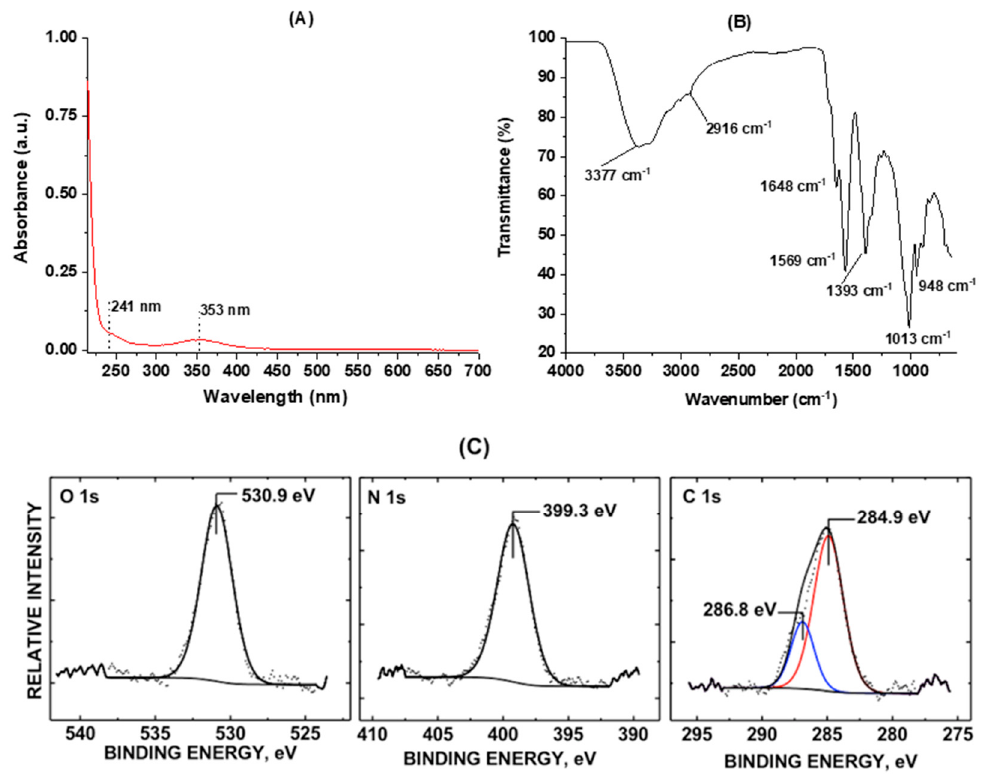
Figure 2. Spectroscopic characterization of the “B-doped” C-dots: ( A ) UV-Vis absorption spectrum of C-dots; ( B ) Fourier-transform infrared (FTIR) spectrum of C-dots with air as background; ( C ) XPS core levels of O 1s, N 1s, and C 1s orbitals of C-dots.